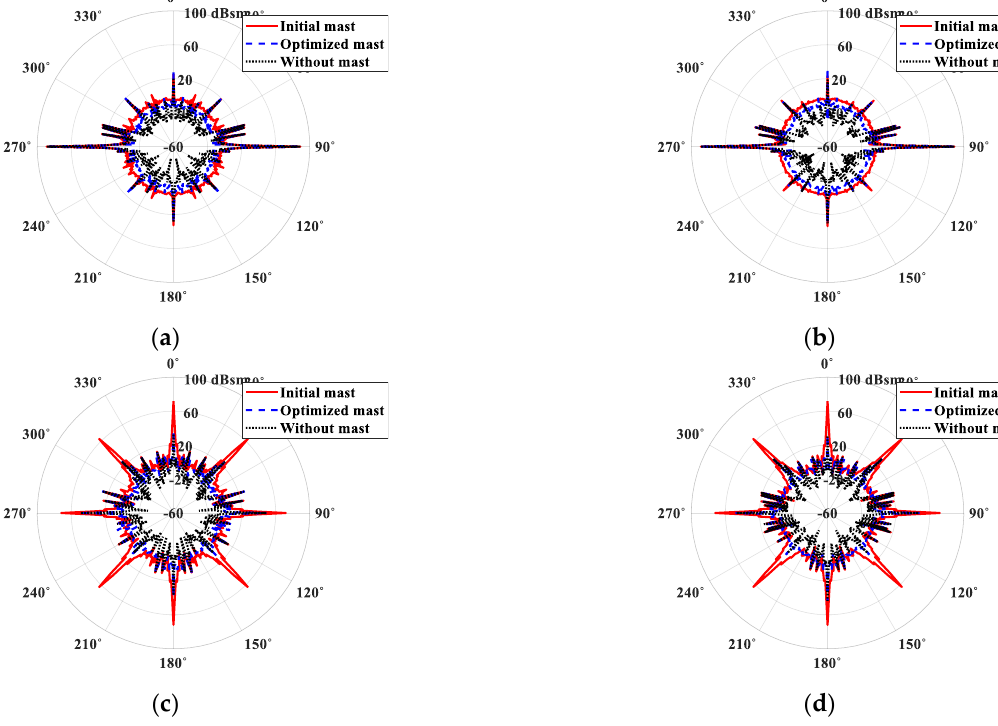
Figure 12. RCS pattern of a naval vessel equipped with the integrated mast in the azimuth plane in the X-band. ( a ) HH polarization at an elevation angle of 0°, ( b ) VV polarization at an elevation angle of 0°, ( c ) HH polarization at an elevation angle of 10°, ( d ) VV polarization at an elevation angle of 10°. Table 3. Geometrical mean of a naval vessel equipped with the integrated mast. (Unit: dBsm).